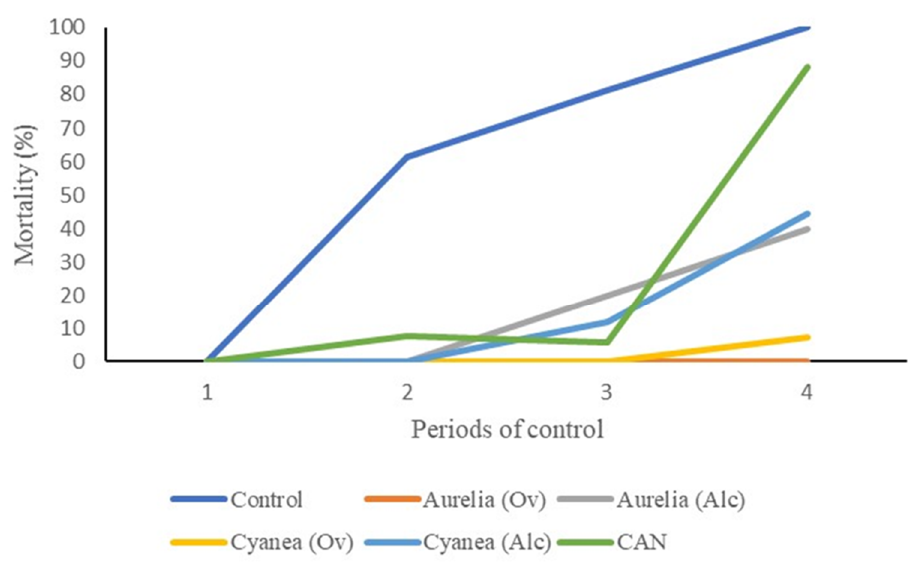
Figure 2. Mortality of seedlings (%) in the pot experiment during the first period of the control (two days).